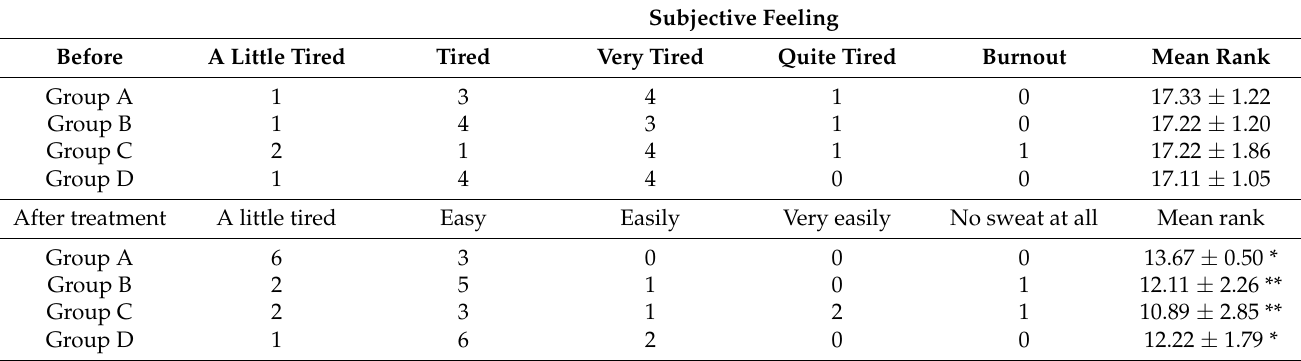
Table 4. The rank of immediate subjective feeling before and after treatment.